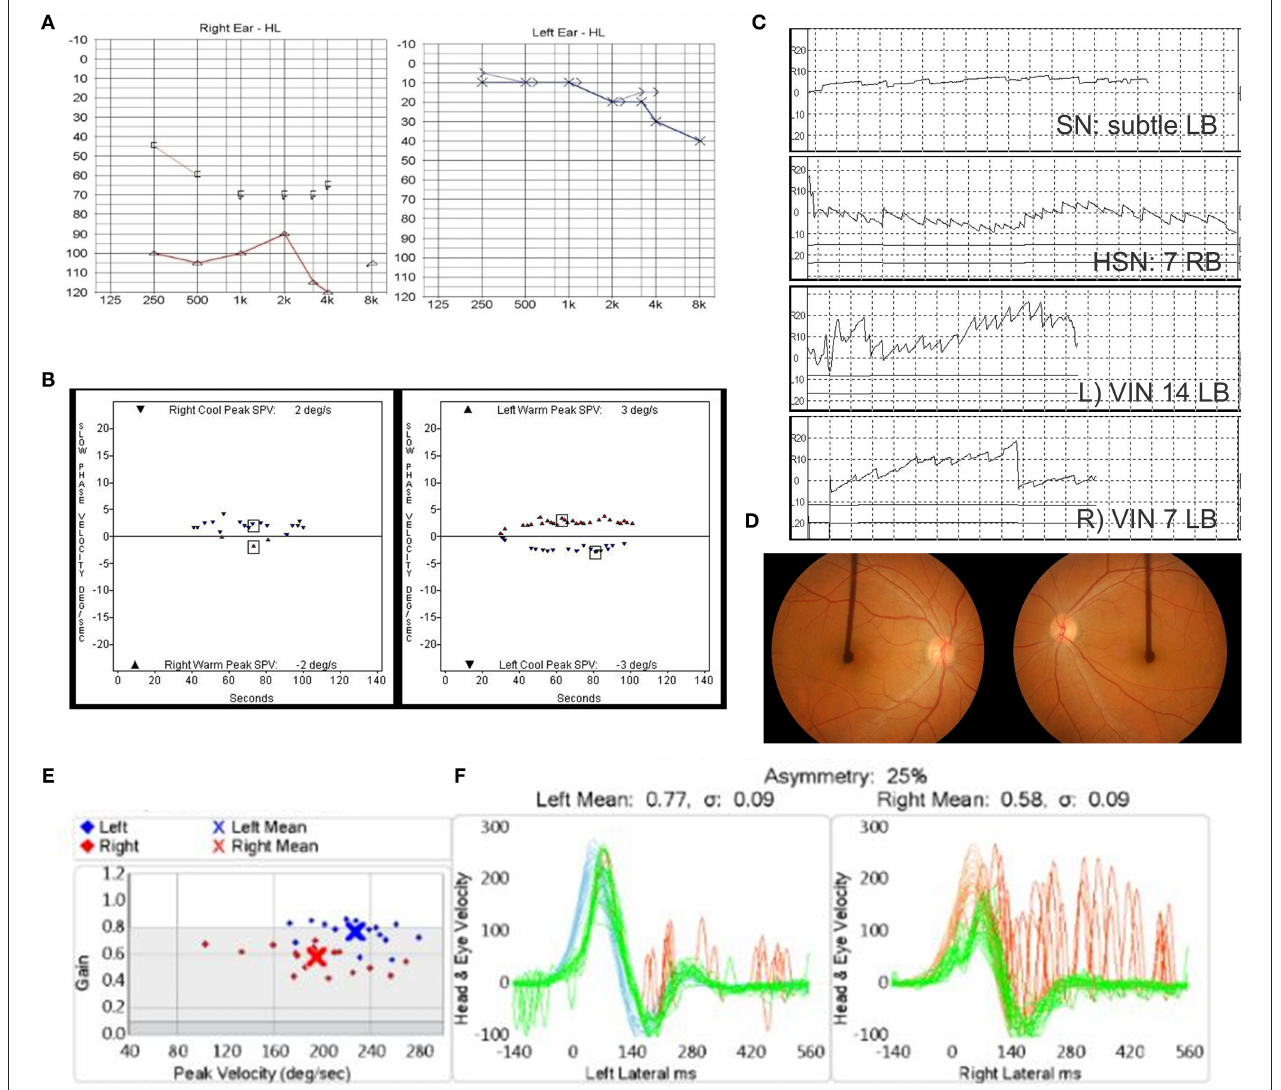
FIGURE 1 | (A–D) Clinical assessment of Case 1 at 4 months after the onset of left vestibular neuritis. (A) Audiometric assessment shows right-side deafness. (B) The bithermal caloric test shows bilateral canal paresis. (C) Subtle left-beating spontaneous nystagmus, headshaking nystagmus (HSN) beating to the right, and vibration-induced nystagmus beating to the left. (D) Fundus photography revealed conjugate counterclockwise torsion from the viewpoint of the patient with extorsion of the right eye (4 ◦ ) and increased extorsion of the left eye (17 ◦ ). (E) The video head impulse test showed vestibulo-ocular reflex (VOR) gain of 0.58 on the right side and 0.77 on the left side 4 years